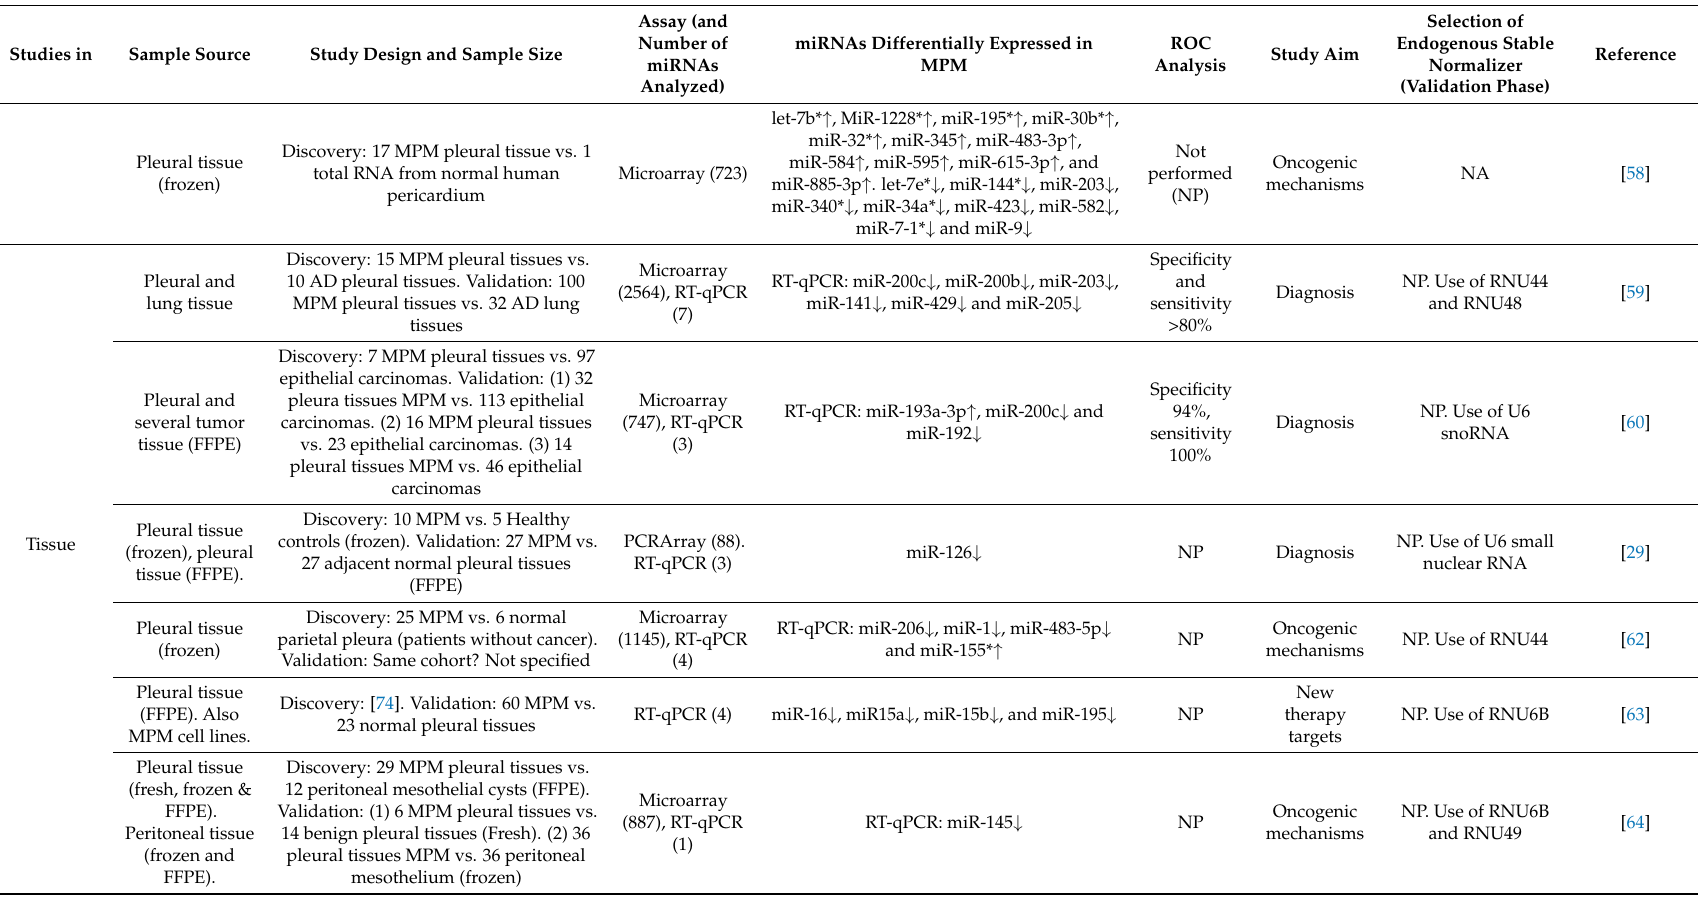
Table 1. Studies regarding tissue and secreted miRNAs differentially expressed in MPM with potential diagnosis biomarker value.